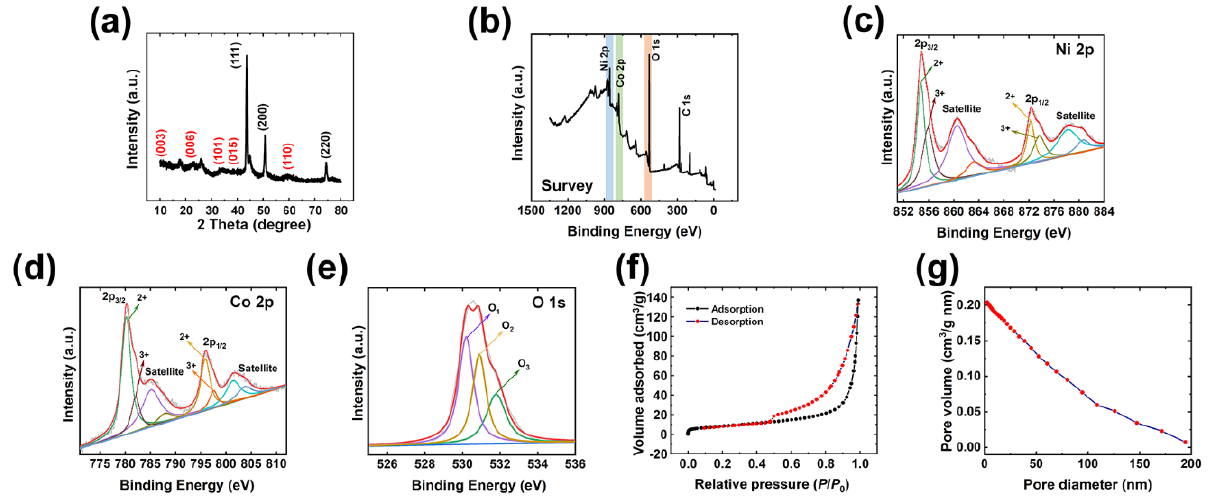
Figure 2. Material analysis including ( a ) X-ray diffractometer (XRD) characterization and ( b – e ) X- ray photoelectron spectroscopy (XPS) characterization of MWC; ( b ) survey, ( c ) Ni 2p, ( d ) Co 2p, and